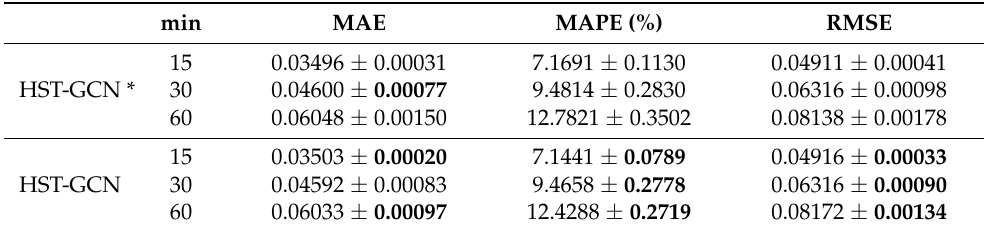
Table 4. Prediction value changes with the distAtt method (“*” indicates that the model did not use the distAtt mechanism). min MAE MAPE (%) RMSE 15 0.03496 ± 0.00031 7.1691 ± 0.1130 0.04911 ± 0.00041 HST-GCN * 30 0.04600 ± 0.00077 9.4814 ± 0.2830 0.06316 ± 0.00098 60 0.06048 ± 0.00150 12.7821 ± 0.3502 0.08138 ± 0.00178 15 0.03503 ± 0.00020 7.1441 ± HST-GCN